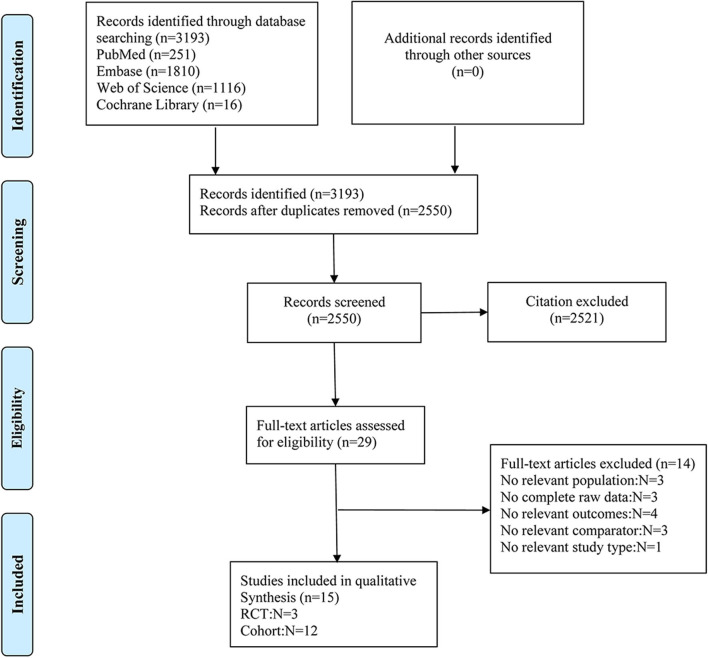
Flow chart of the evidence search and selection process.